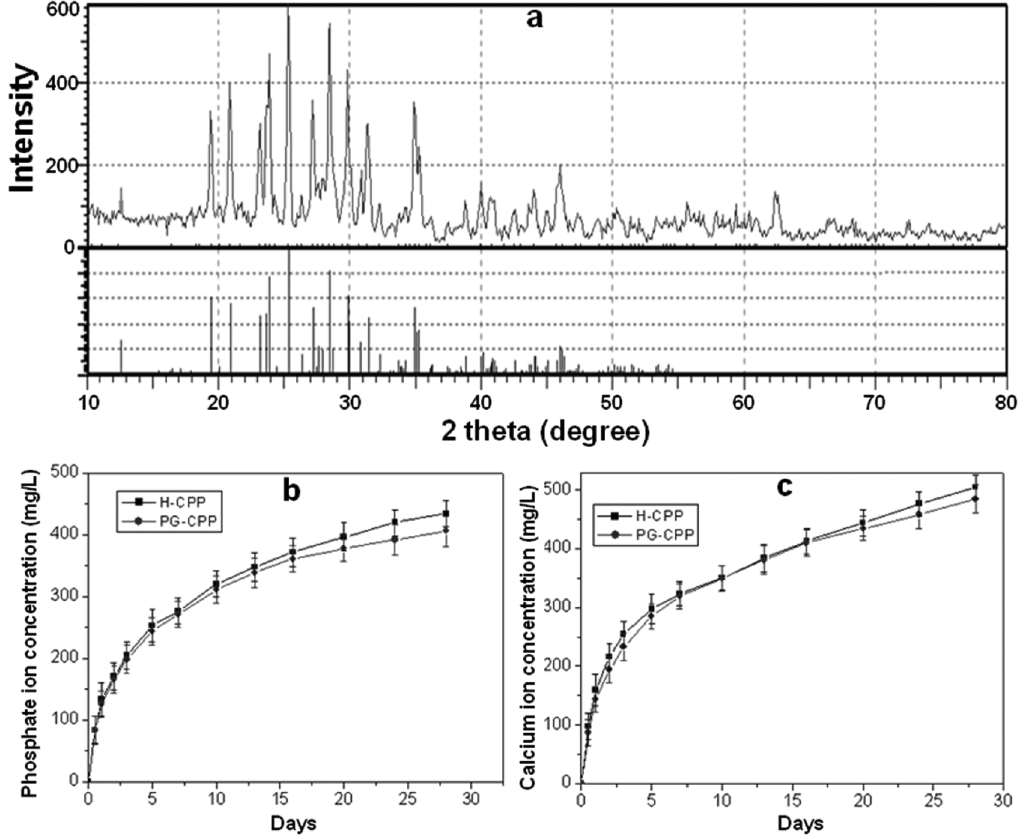
Fig. 2 – (a) XRD pattern of calcium polyphosphate obtained in this work, and the PO 3− ion (b) and Ca 2+ ion (c) concentration during the degradation in the Tris-HCl buffer solution (pH 7.4).